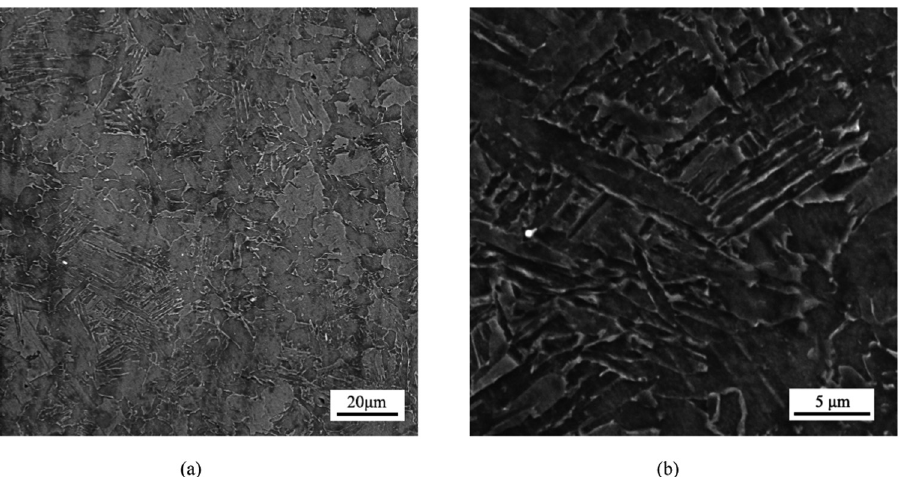
Figure 10: SEM images of the specimen subjected to CHT with decreasing temperature: ( a ) 1,000 × ; ( b ) 5,000 × .